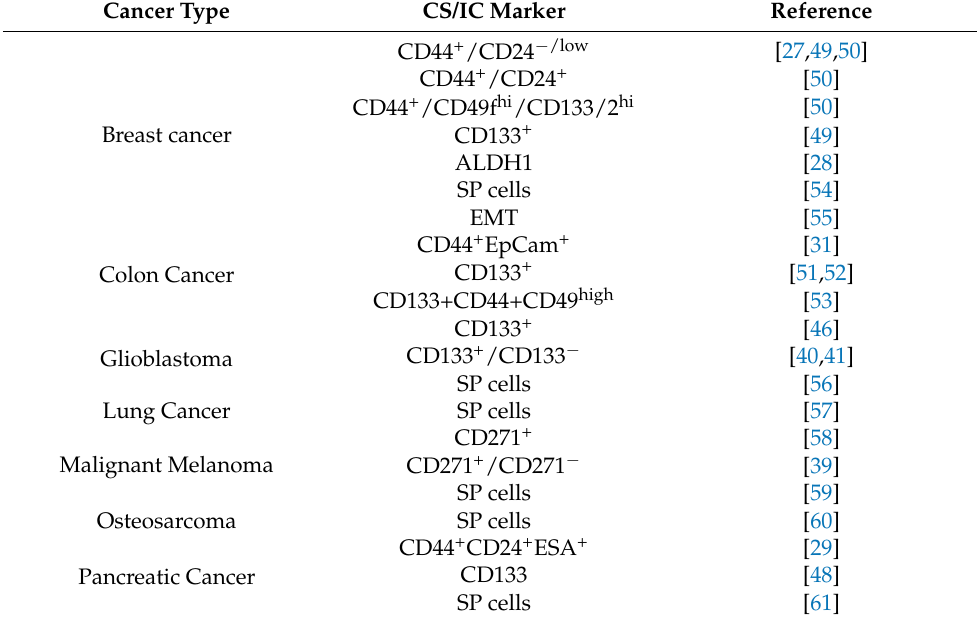
Table 1. Prospective CS/IC